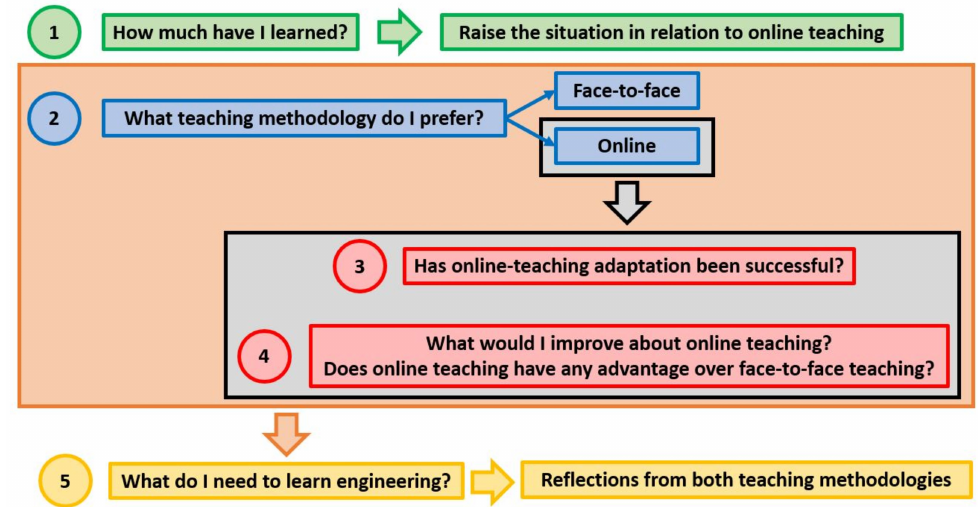
Figure 1. Schema of thought processes when completing the